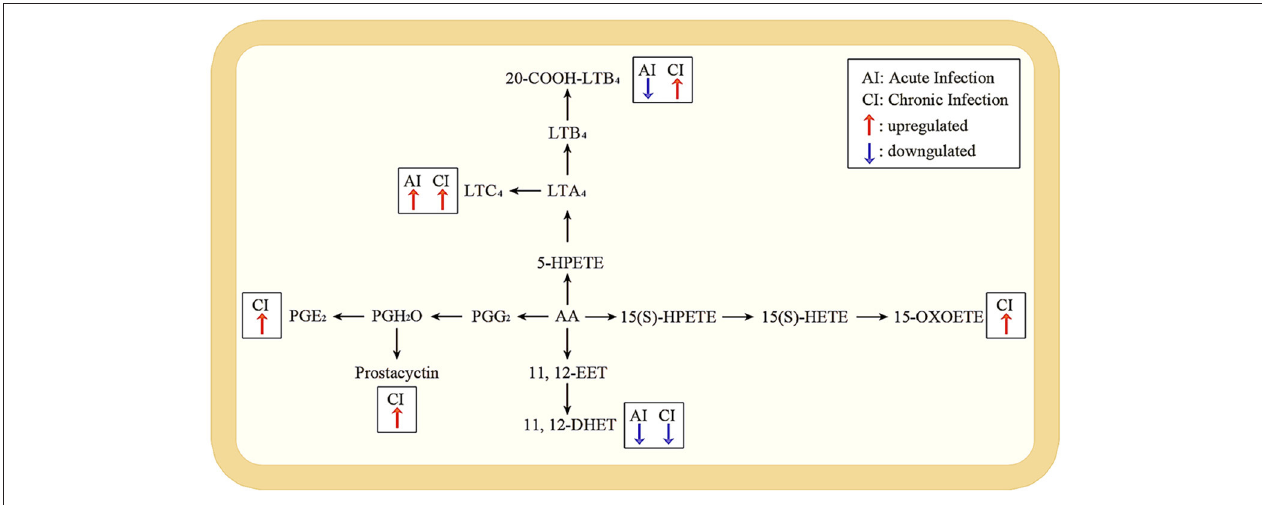
FIGURE 6 | Pathway analysis of arachidonic acid metabolism during acute and chronic infection. A schematic illustration of arachidonic acid metabolism pathway; the most significant differentially expressed metabolites during acute and chronic infection phases. Red and blue arrows represent upregulated and downregulated metabolites. The metabolites without arrows are not changed. In the acute infection, Leukotriene C4 (LTC4) was upregulated whereas 20-COOH-LB4 and 11,12-DHET were downregulated; but in the chronic infection, LTC4, 20-COOH-LB4, Prostaglandin E2 (PGE2), Prostacyctin and 15-OxoETE were upregulated with only 11,12-DHET being